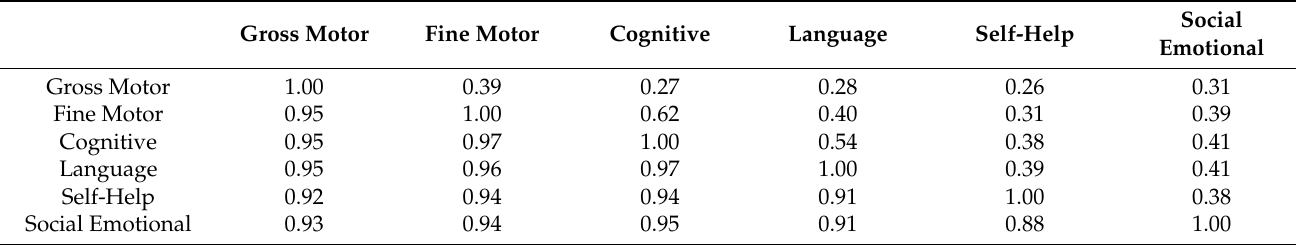
Table 8. Zero-order correlations and partial correlations, controlled for age, among the C-LAP’s six domains among participants from Shanghai between 2016 and 2019.